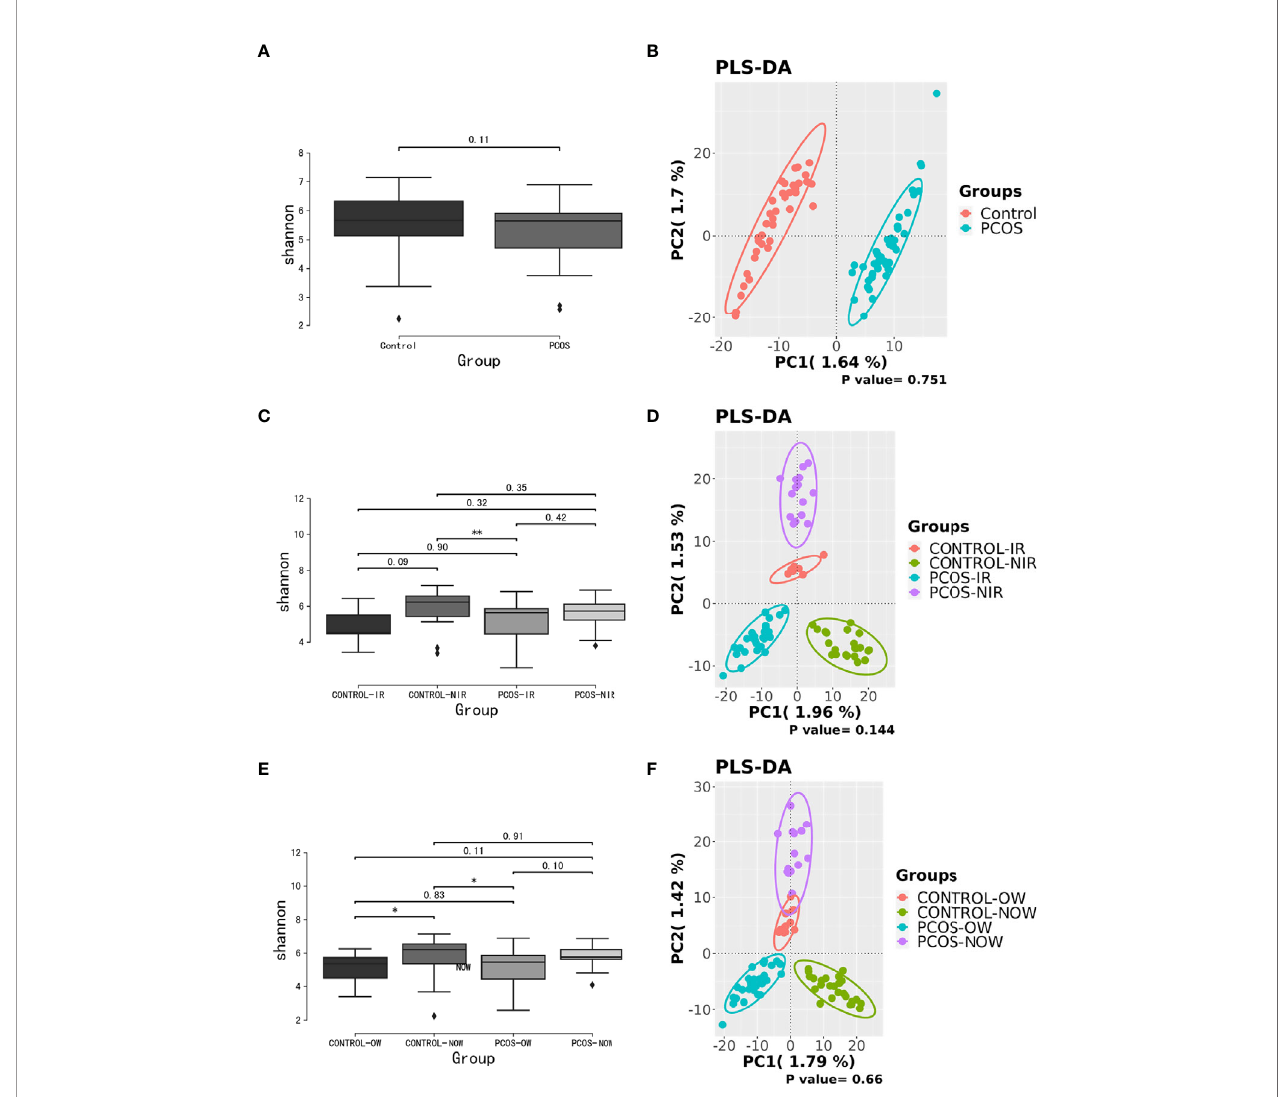
FIGURE 1 | Biodiversity of the gut microbiome of participants on the ASV level. (A) , Alpha diversity comparison between PCOS and control groups with a box plot of the Shannon index. (B) , Partial least squares-discriminate analysis (PLS-DA) score plot of amplicon sequence variant (ASV) abundance in PCOS and control groups. (C, D) , Alpha diversity comparison and PLS-DA score plots between groups further divided by HOMA-IR. (E, F), Alpha diversity comparison and PLS-DA score plots between groups further devided by BMI. BMI, body mass index; HOMA-IR, homeostasis model assessment; PCOS, polycystic ovary different microbiota species in the samples is shown in Figure 4 .